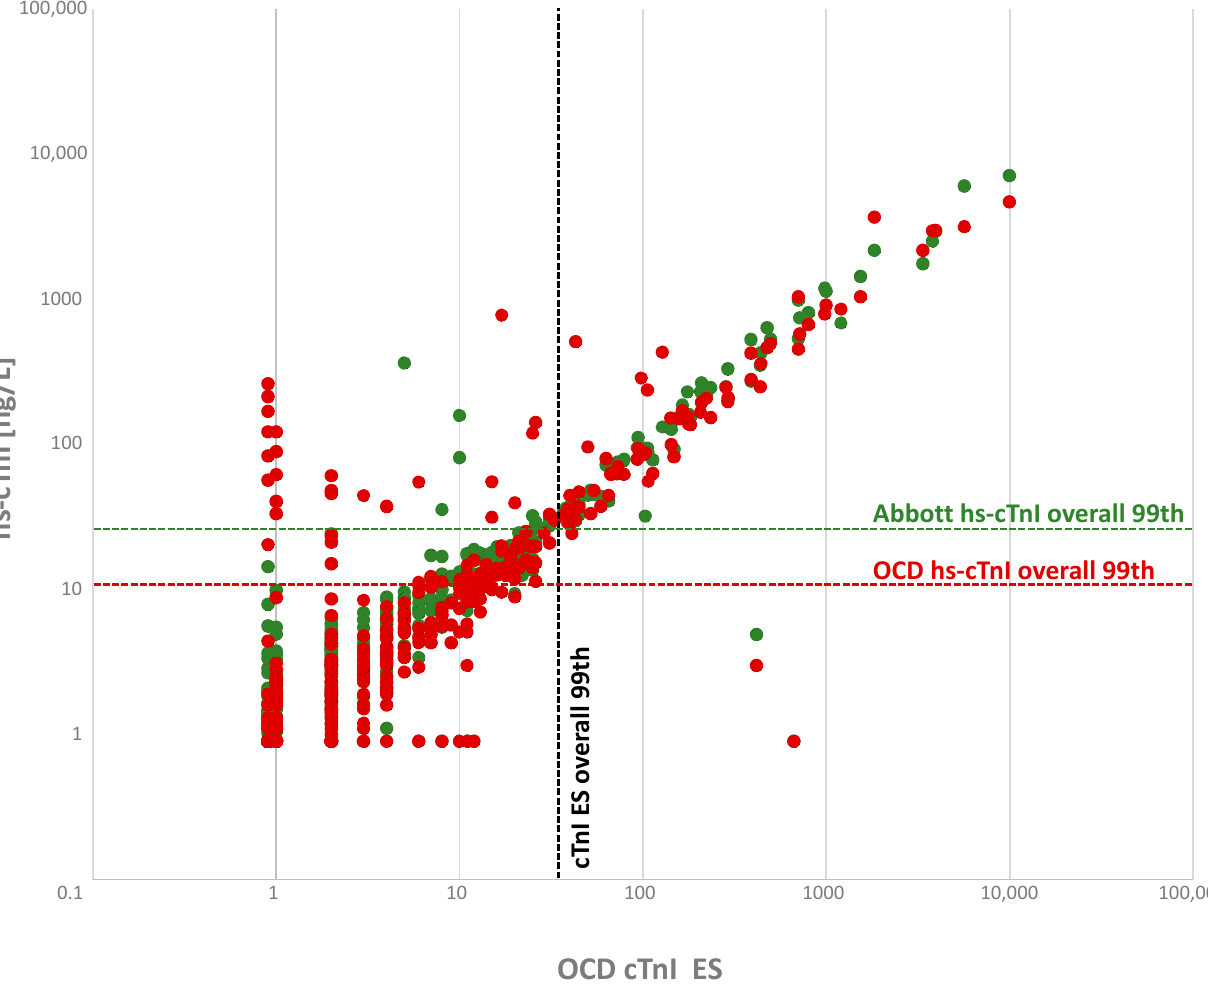
Figure 1. Comparison between the Ortho Clinical Diagnostics’ (OCD) hs-cTnI assay (red circles) and the Abbott hs-cTnI assay (green circles) versus the OCD cTnI ES assay in lithium heparin plasma. The regions where there is disagreement between assays regarding biochemical injury can be identified by the 99th percentile upper reference limit (ULR) cutoffs/dashed lines (black dashed line OCD cTnI ES 99th, red dashed line OCD hs-cTnI 99th, green dashed line Abbott hs-cTnI 99th).